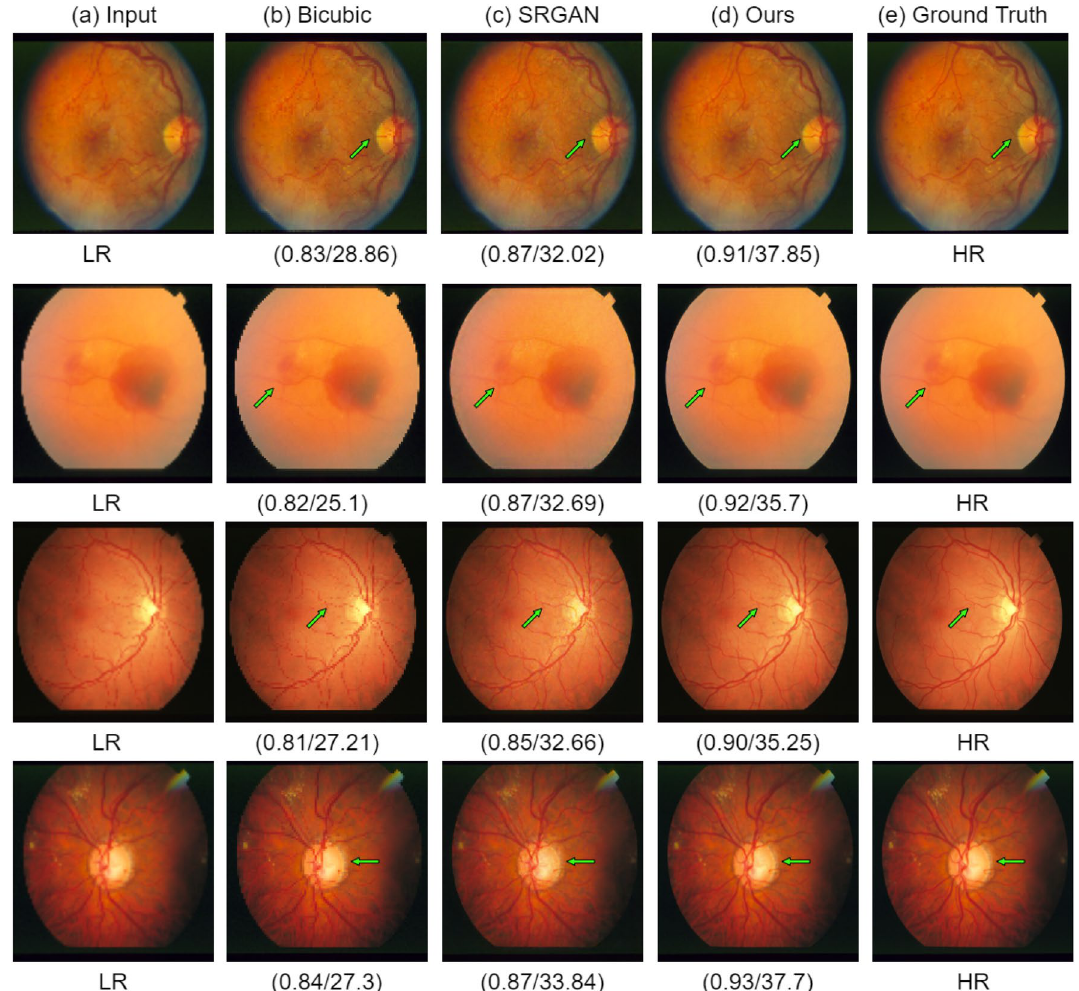
Figure 6. Results of super resolution for different images of STARE dataset. The column ( a ) has LR images (128 × 128 but scaled for uniform display), column ( b ) shows Bicubic interpolation SR result, column c shows output HR images for SRGAN 31 , column d shows output HR images for the proposed architecture, column e shows ground truth HR images (512 × 512). Each row illustrates results of a single image. The corresponding (SSIM/PSNR) scores are mentioned below each image. Green arrows illustrate the degradation or improvement caused by each algorithm with respect to the ground truth HR